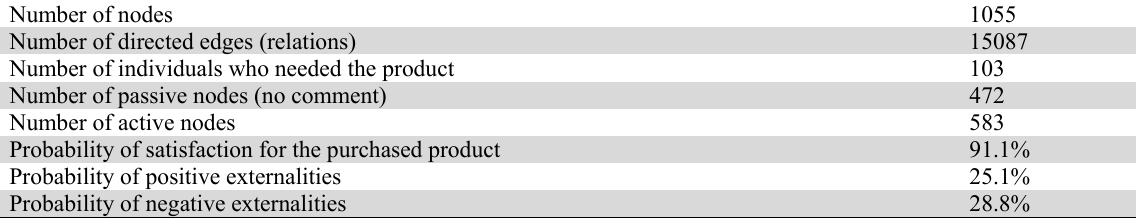
Profile of the collected social network